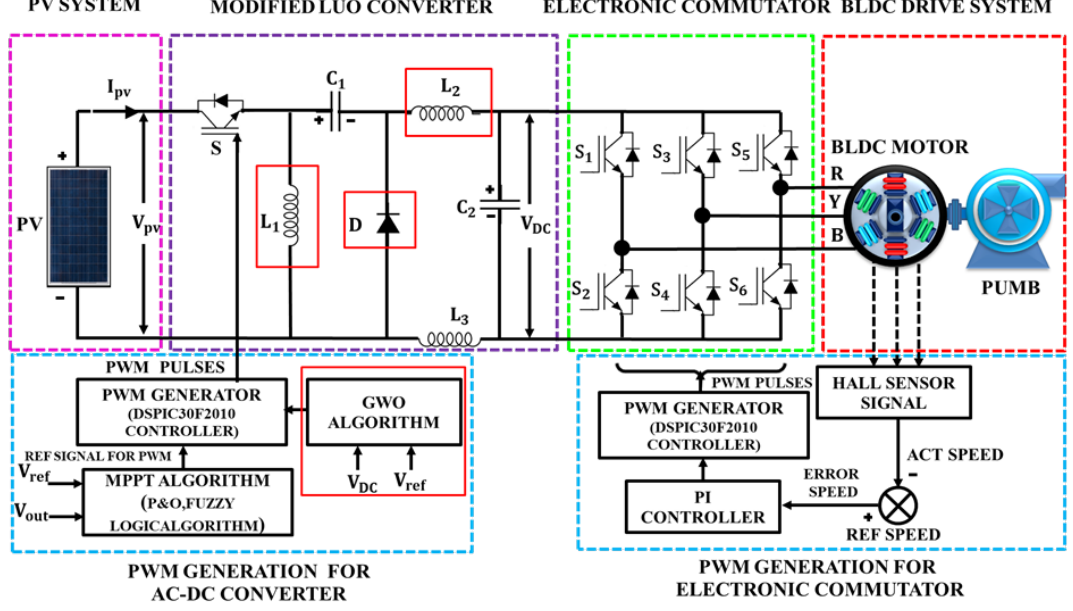
Figure 1. Proposed solar-based system for motor pumping.